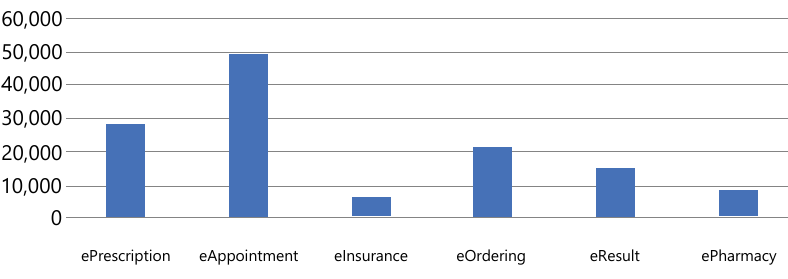
Figure 3. Frequency of usage of the eHealth services in Montenegro in 2020.